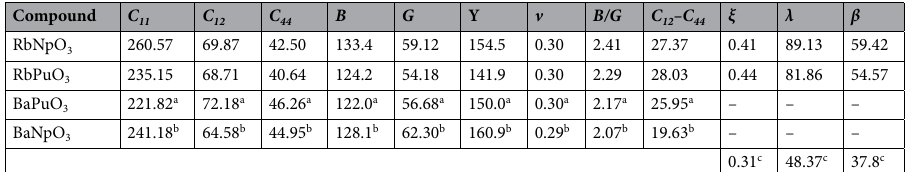
C 44 ), Kleiman’s parameter ( ξ) −